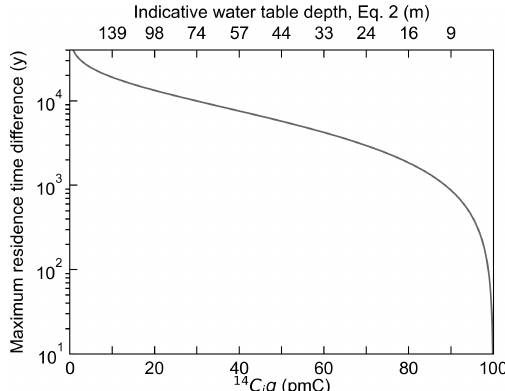
Figure 6. Maximum difference in calculated MRT ( y ), where 14 C i q on the x axis is used, relative to the case where it is assumed to be 100pmC. The secondary x axis shows indicative water depths that correspond to 14 C i q values shown on the lower x axis according to Eq. (2). The result assumes q =